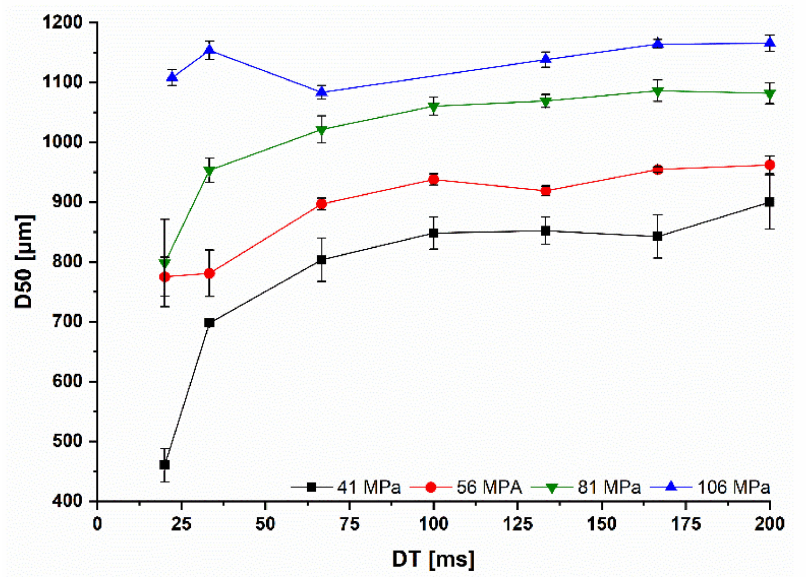
Figure 9. Influence of the dwell time on the median granule size D50 of MCC granules at different P max from 41 to 106 MPa; x ± s ; n =